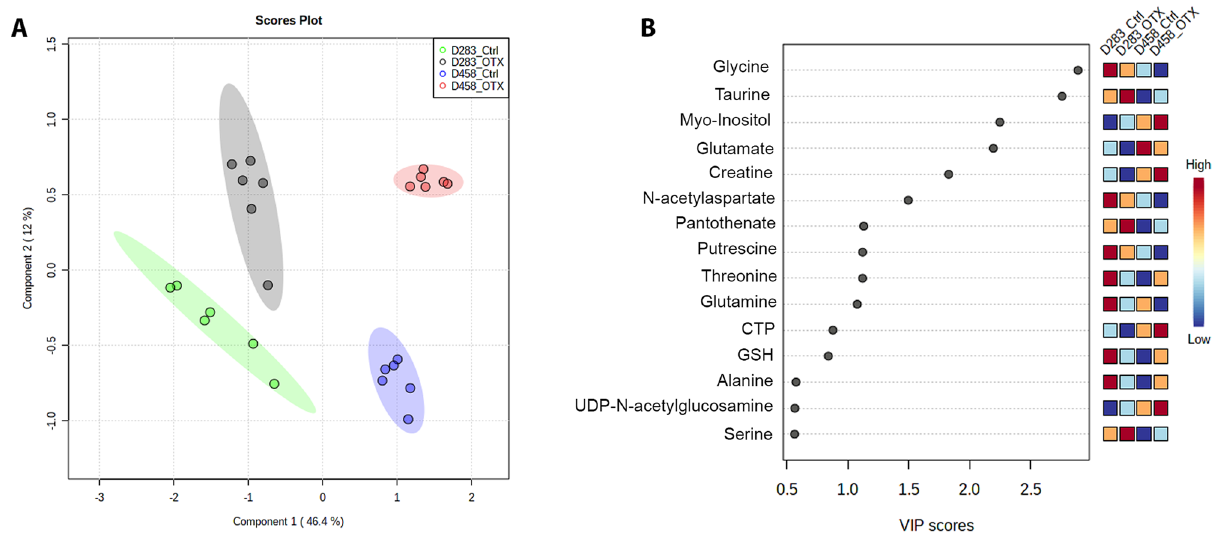
Figure 3. ( A ) Score scatter plot showing PLS-DA analysis of the full spectra of 1 H NMR data, where peak intensities of metabolites represent the variables. The spatial distribution of the samples is based on the metabolite pattern. Six biological replicates were used for this analysis. ( B ) Variable importance of projection (VIP) score was plotted for the metabolites that significantly contributed (VIP ˃ 1) to separation by